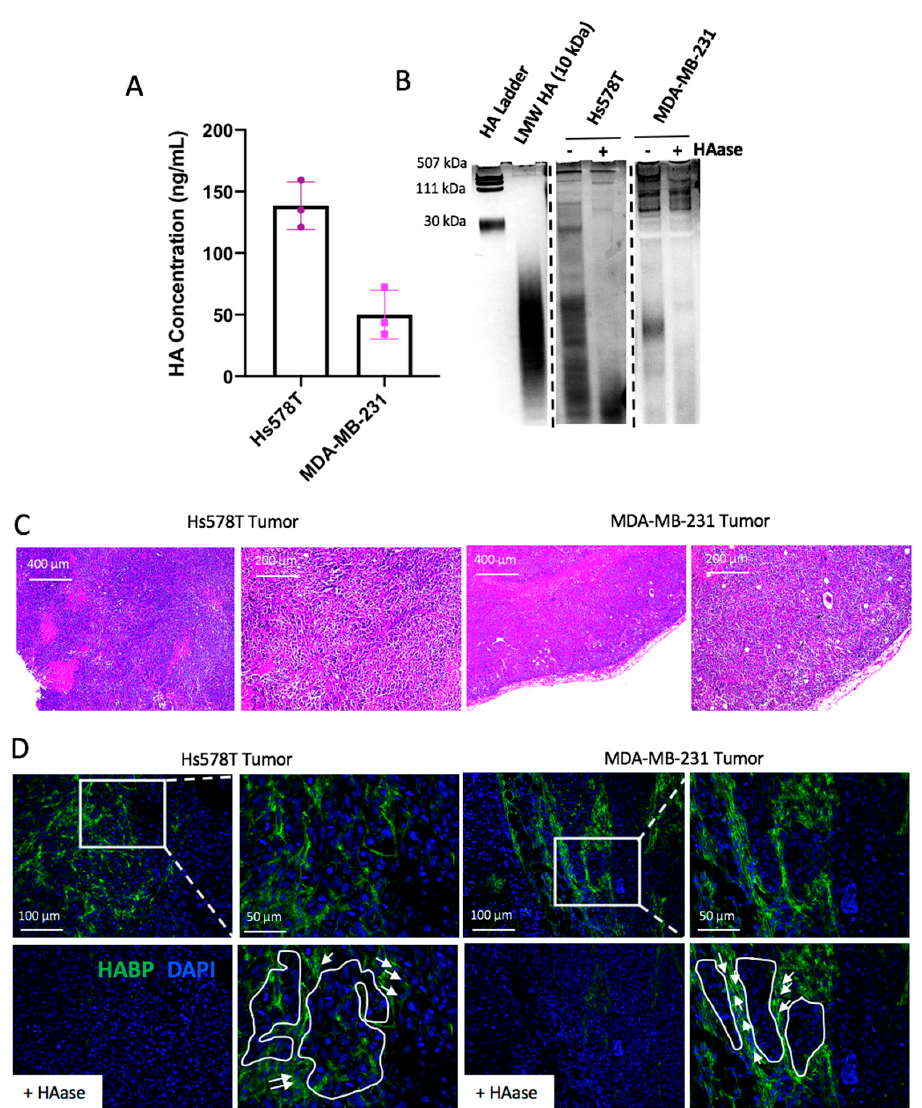
Figure 2. Hyaluronan synthesis and fragmentation in breast cancer cell lines. ( A ) HA production by Hs578T and MDA-MB-231 cell lines as determined by ELISA. Data points represent individual experiments. Error bars represent standard error of the mean. ( B ) HA fragmentation analysis via gel electrophoresis in Hs578T and MDA-MB-231 cell lines. HA was isolated from cell supernatants, protein was removed via proteinase K, and samples were precipitated using 100% ethanol. A portion of each sample was treated with hyaluronidase as a control to ensure degradation of HA fragments (+HAase). ( C ) Morphology (hematoxylin and eosin stain) of triple negative breast cancer xenografts in vivo. Representative 50× and 100× magnification images are shown. ( D ) Immunofluorescence microscopy for hyaluronic acid binding protein (HABP; green) and DAPI nuclear stain in the triple negative xenograft models. Inserts identify regions of heterogeneous HA staining, with both HA-high and HA-low/absent regions present within animal models of disease. Tumor nests surrounded by hyaluronan are outlined in white. White arrows call out interspersed stromal cells embedded in the HA-rich stroma surrounding the tumor nests, which are likely fibroblasts or monocyte/macrophages, based on the small, slightly elongated, and smoothly contoured nuclear morphology (specific stains to further elucidate were not performed). As a control, each section was treated with hyaluronidase prior to staining (+HAase). Each image was taken at 200× and 400× magnification. For large format 400× images depicting tumor nests and stromal cells, refer to Figure S1.